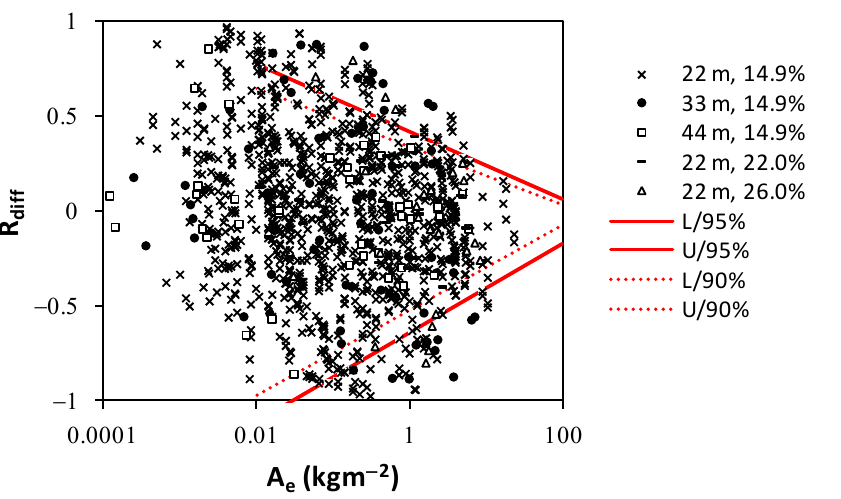
Figure 8. Relative differences in measurements of soil loss between replicated plots, R diff , vs. the measured soil loss value, M , for all plots established at the Sparacia station and 90 and 95% occurrence intervals for the data (L = lower limit; U = upper limit) calculated according to [39] (modified from [40]).